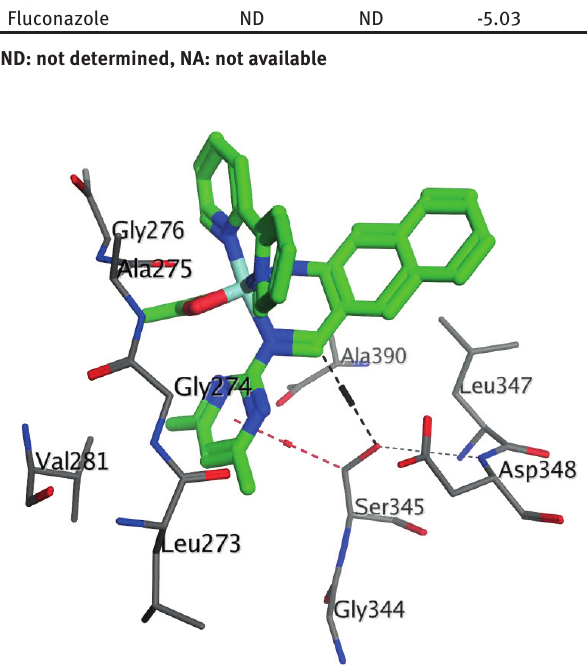
Figure 9: 2HCK-[Zn(L)(bipy)(OAc)]∙H Figure 9: 2HCK- [Zn(L)(bipy)(OAc)] ∙ H 2 O complex.